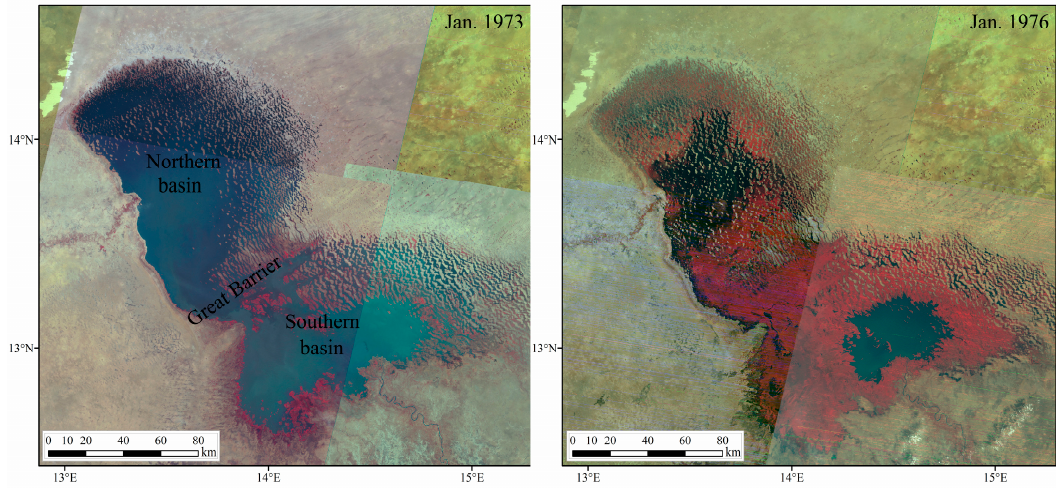
Figure 2. The serious lake recession of Lake Chad observed from Landsat images.